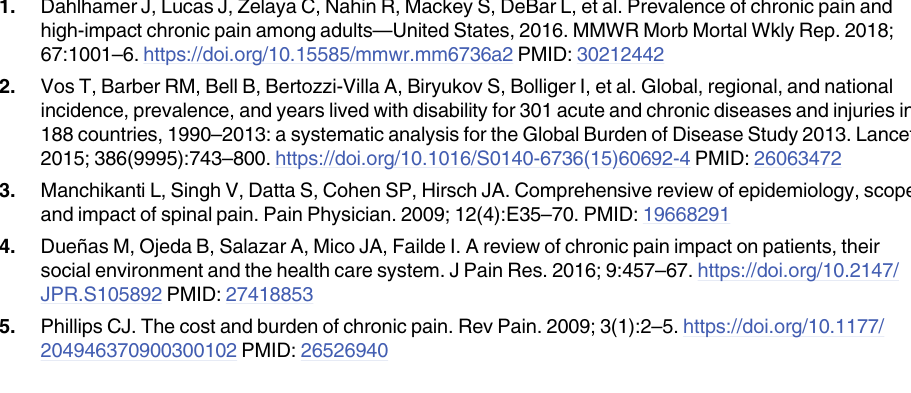
S2 Table. Total number of errors committed during explicit motor learning. S3 Table. Implicit motor learning: Within group and between group differences in hand path distance. S4 Table. Total number of errors committed during implicit motor